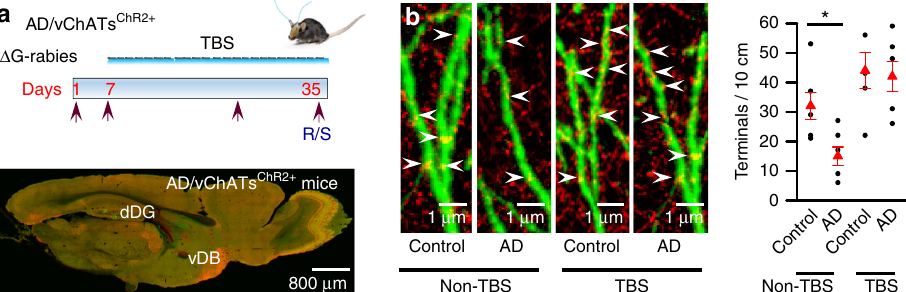
Fig. 6 TBS increases cholinergic synaptic inputs in AD mice. a Experimental schedules (top) show that Δ G-rabies-ChR2 virus injection in the AD/NGIs TVA/ G+ mice at 150 ± 5 days old of age resulted in AD/vChATs ChR2+ mice. The mice were applied with 28-days TBS at 7 days after the virus injection. Electrophysiological recordings and staining (R/S) were performed immediately after TBS. A representative image indicates the ChR2-GFP expression in vChATs neurons of the AD/vChATs ChR2+ mice. b Representative images reveal the ChATs-labeled terminals targeting at the individual dNGIs. A plot shows the actual (black circles) and the averaged numbers (red triangles) of terminals/10 cm dendrites (mean ± SEM, n = 5 mice/group, F 1.19 = 10.8, * p = 0.0051, two-way